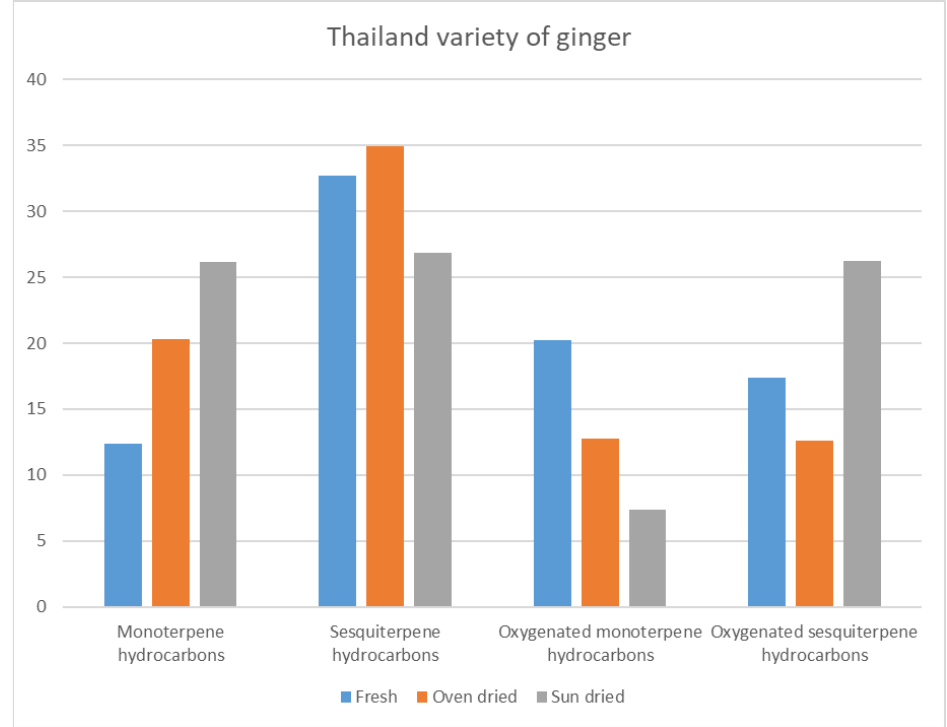
Figure 2. Variations in major classes of compounds in essential oils of fresh, OD, and SD pretreatment Thailand ginger.